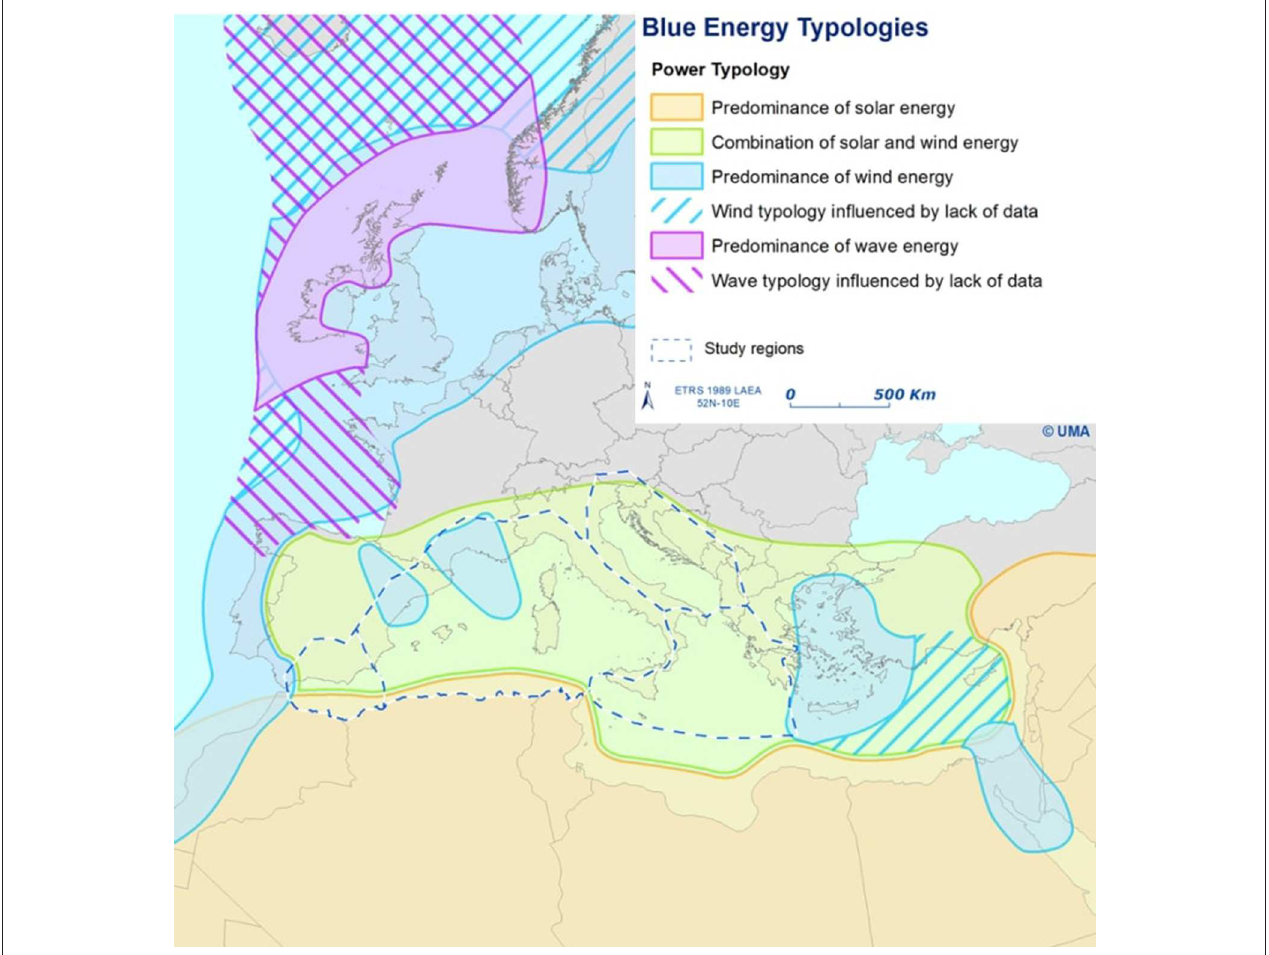
FIGURE 1 | Blue Energy Typologies in Europe. Reproduced from ASME (Abanades et al., 2018a) based on information of Aqua-RET